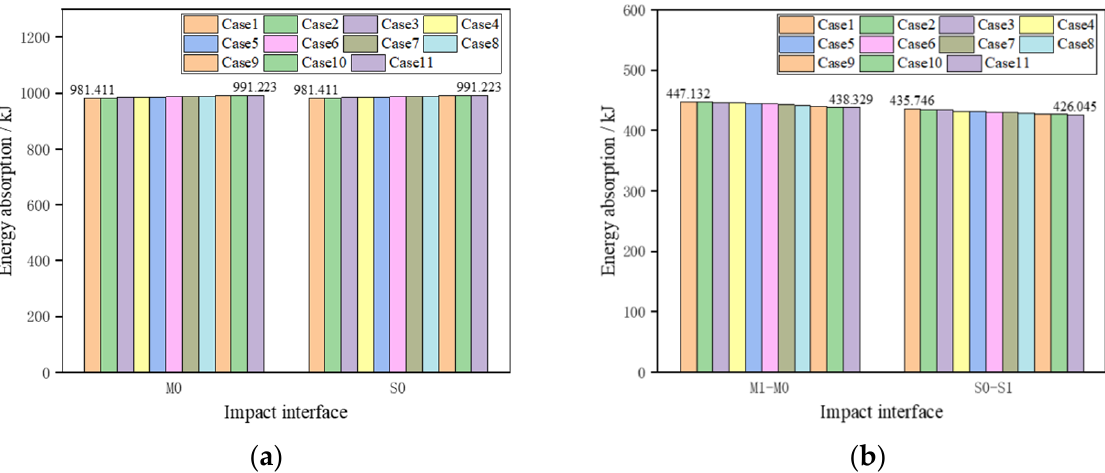
( b ) Figure 9. Influence of initial peak force change on overall train collision energy: ( a ) broken line graph, ( b ) bar chart. It can be seen from the line graph that, except for the M0–S0, M1–M0 and S0–S1 im- pact interfaces, the change in F max of the anti-climbing energy-absorbing structure has ba- sically no effect on other interfaces of the train energy broken line. Further observation of the bar chart shows that the energy absorption of the head car impact interface M0–S0 will increase with the variation in F max , while the energy absorption of the two middle car in- terfaces M1–M0 and S0–S1 will reduce. Figure 10 shows the change in the energy absorption of the head cars S0 and M0, and the middle car impact interfaces M1–M0 and S0–S1 with the initial peak force. The energy absorption of the head car increased from 981 kJ to 991 kJ with the increase in the initial peak force, while the energy absorption of the middle car impact interfaces M1–M0 and